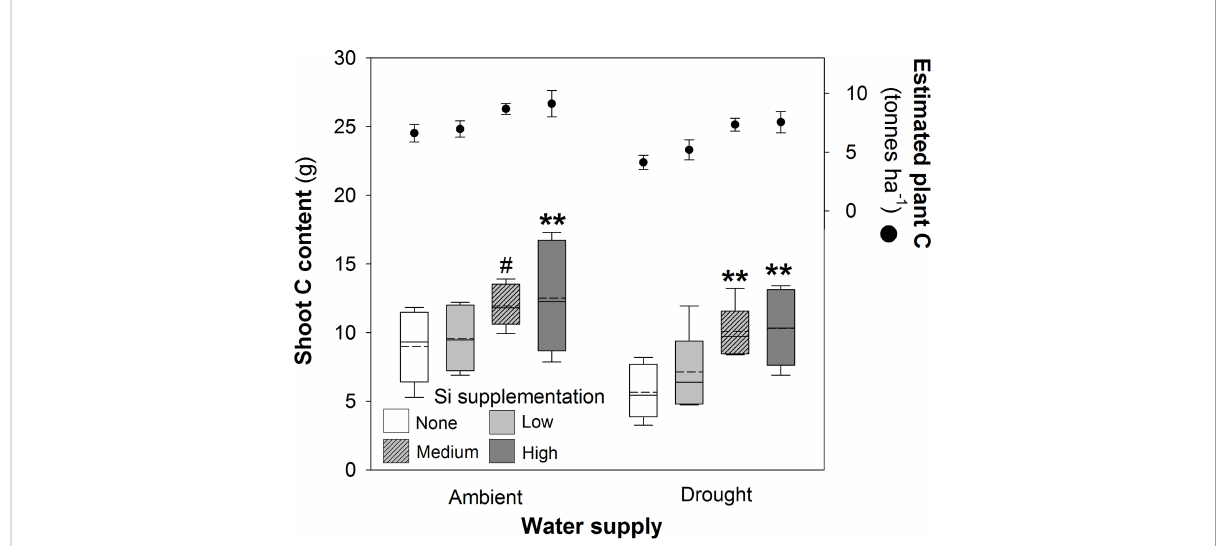
FIGURE 4 Shoot C content of plants grown with Si supplementation (low, medium and high; 39, 78 and 117 kg ha -1 ) compared to plants without Si supplementation (none) under ambient and drought conditions (details as in Figure 2; N = 6). Statistically signi fi cant differences between Si